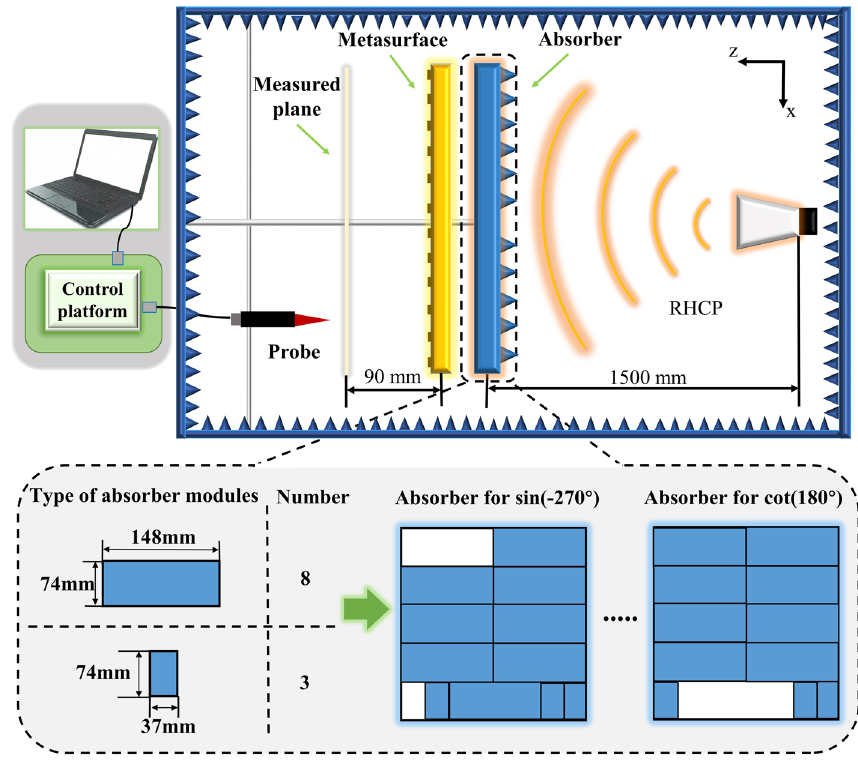
Fig. 5 Schematic diagram of the measured scenario for the optical trigonometric operator. The inset shows the design of the shaped incident beam that performs as the input